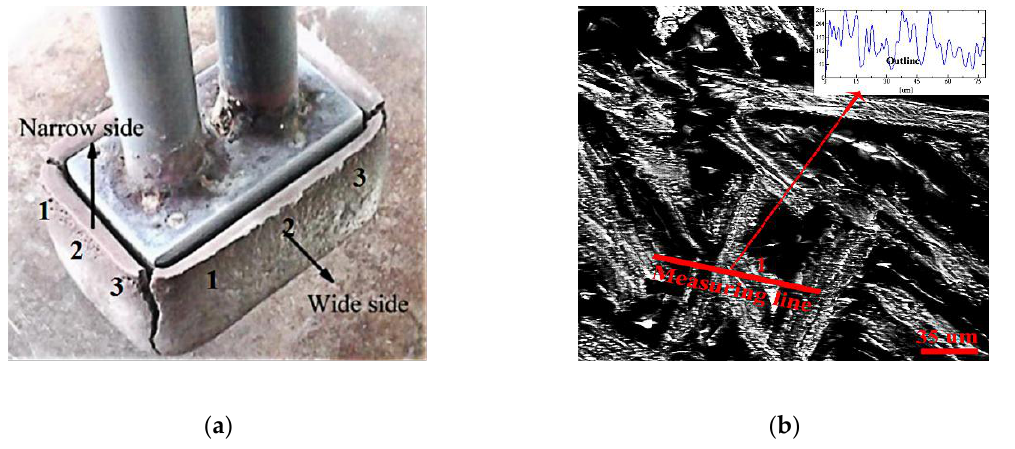
Figure 2. Measuring methods of ( a ) mean slag film thickness and ( b ) mean surface roughness of slag films.